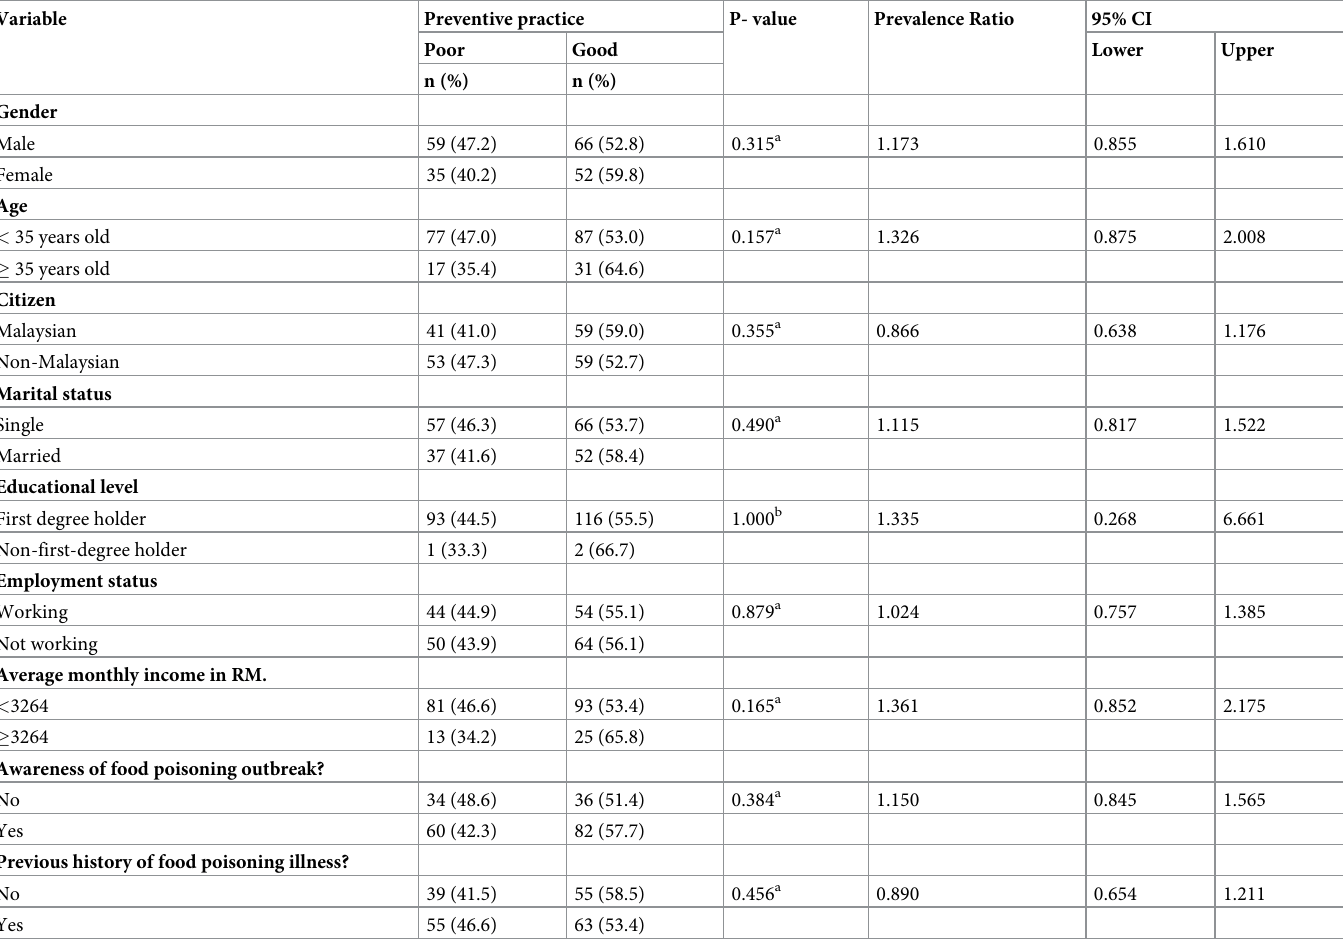
Table 16. Association between demographic and socioeconomic factors, awareness of food poisoning outbreak, and the previous history of food poisoning illness with the preventive practice of food poisoning among the respondents (n =